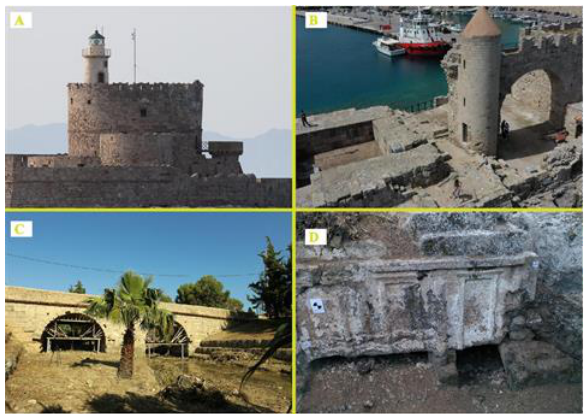
Figure 1 . The four study areas in